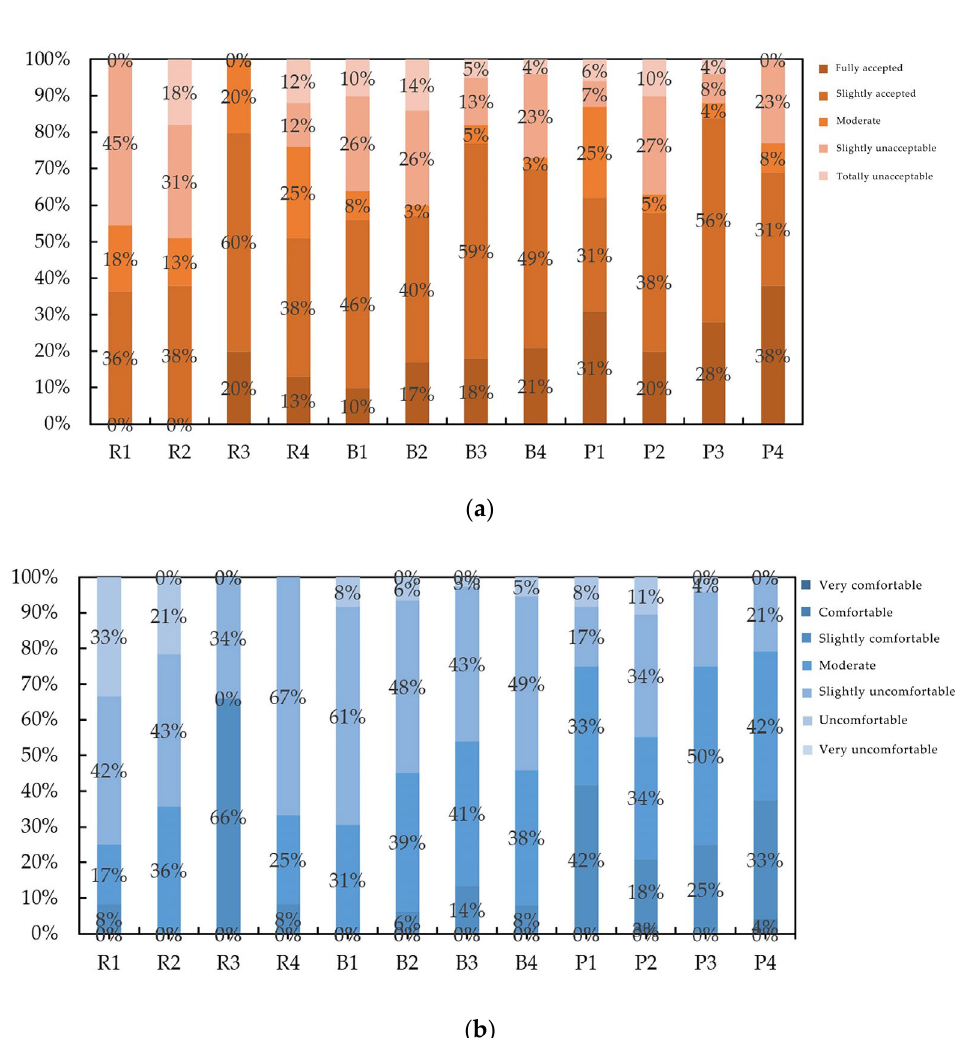
Figure 6. Crowd Heat Comfort Voting: ( a ) Thermal Sensory Voting (TSV); ( b ) Thermal Comfort Voting (TCV).